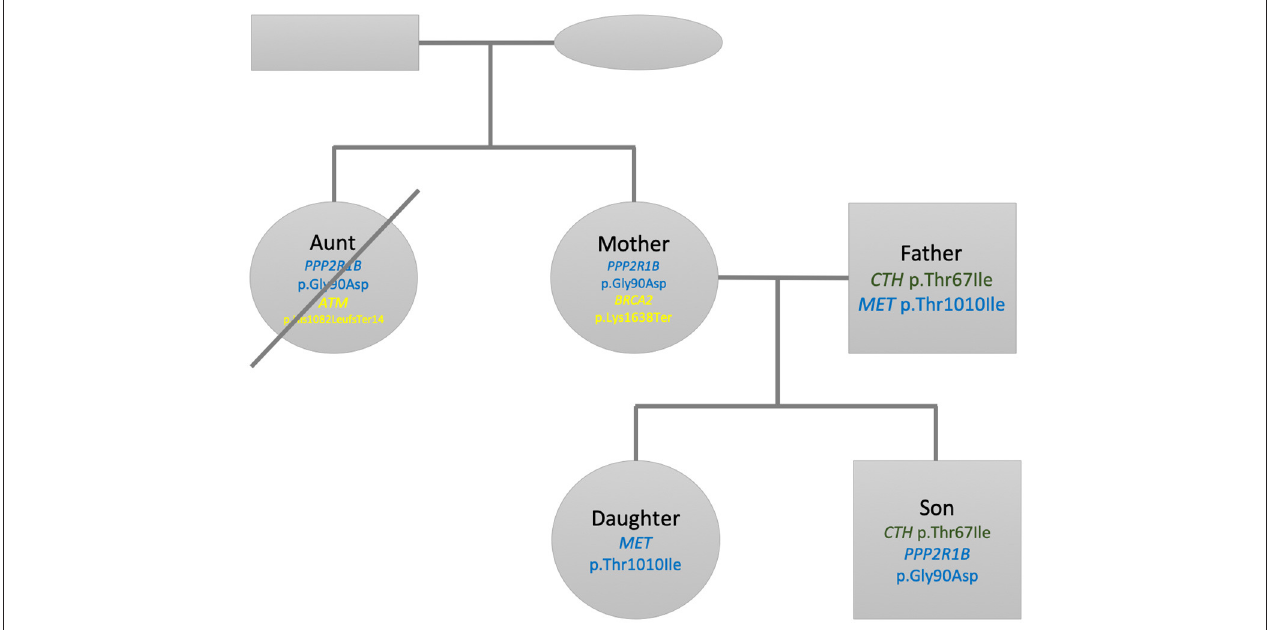
FIGURE 2 | Family pedigree showing the relationship, gender (square: male, circle: female), and variants found listed within each individual. Green variants are inferred as benign, blue are variants of unknown significance and yellow pathogenic variants according to ACMG scoring. The crossed circle indicates a deceased individual.